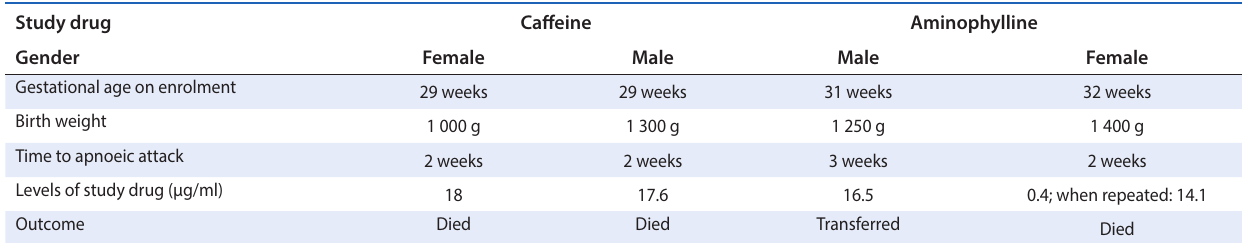
Table 2: Background data of patients who developed apnoeic attacks Study drug Caffeine